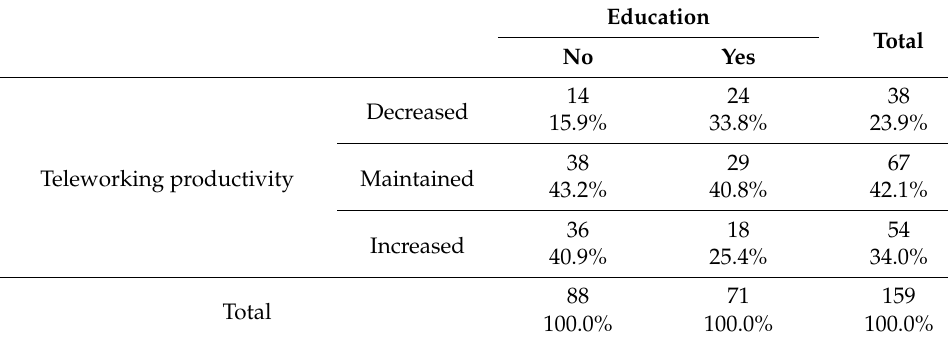
Figure 10. Solutions to minimize the negative impacts of telework.